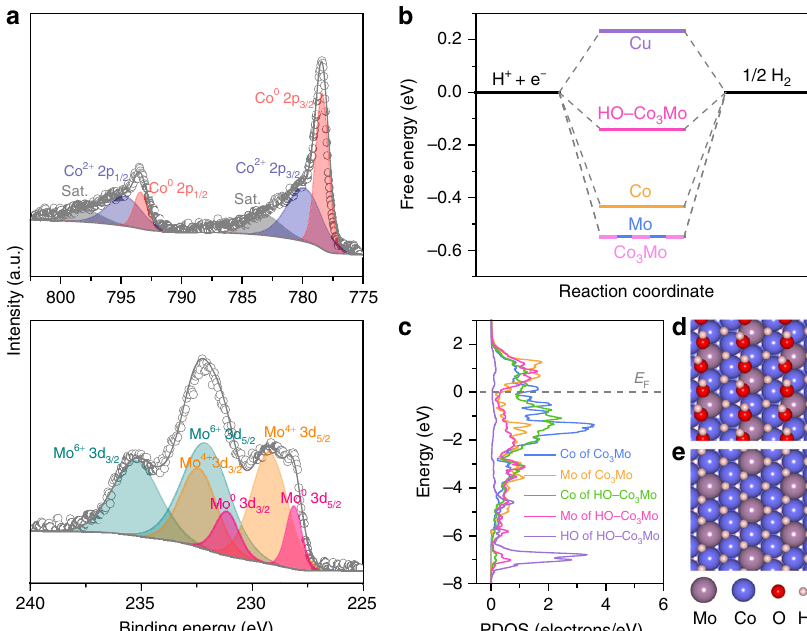
Fig. 2 XPS characterization and DFT simulation. a High-resolution Co 2p (top) and Mo 3d (bottom) XPS spectra of nanoporous Co 3 Mo/Cu electrode. b Free-energy diagram for hydrogen (H*) adsorption on 1/2 ML HO*-adsorbed Co 3 Mo surface and pure Cu, Co, Mo, and Co 3 Mo surfaces. c Partial density of states (PDOS) of Co, Mo in Co 3 Mo and Co, Mo, HO in the 1/2 ML HO*-adsorbed Co 3 Mo. d , e Schematic structures of Co 3 Mo with/without the 1/2 ML HO*